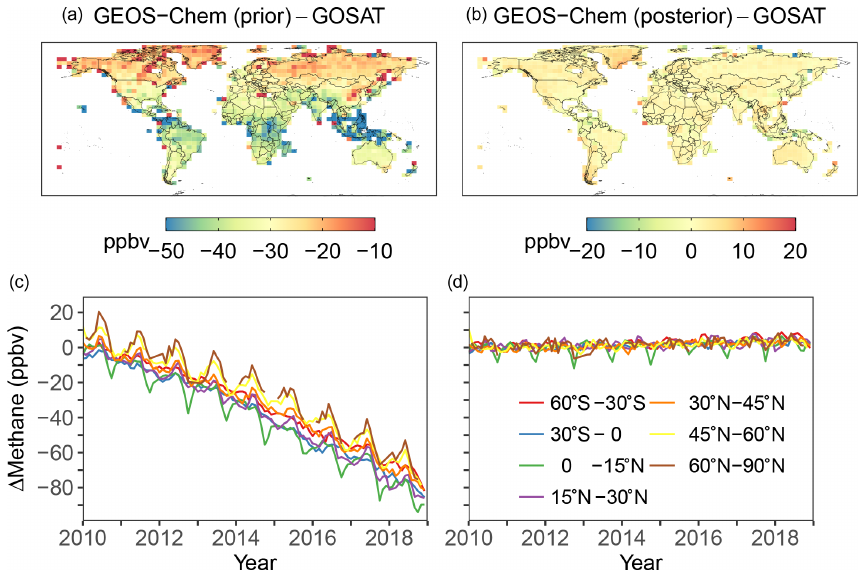
Figure 3. Difference in methane columns between GEOS-Chem simulations and GOSAT observations. Results are shown for GEOS-Chem using prior (a, c) and posterior (b, d) state vector estimates as well as for the spatial distribution averaged during 2010–2018 (a, b) and monthly time series of zonal means in different latitude bands (c, d) . Note the different color scales in (a) and (b) . Tick marks on the x axes in (c) and (d) represent January in each year. Figure S6 plots panel (d) in an expanded ordinate